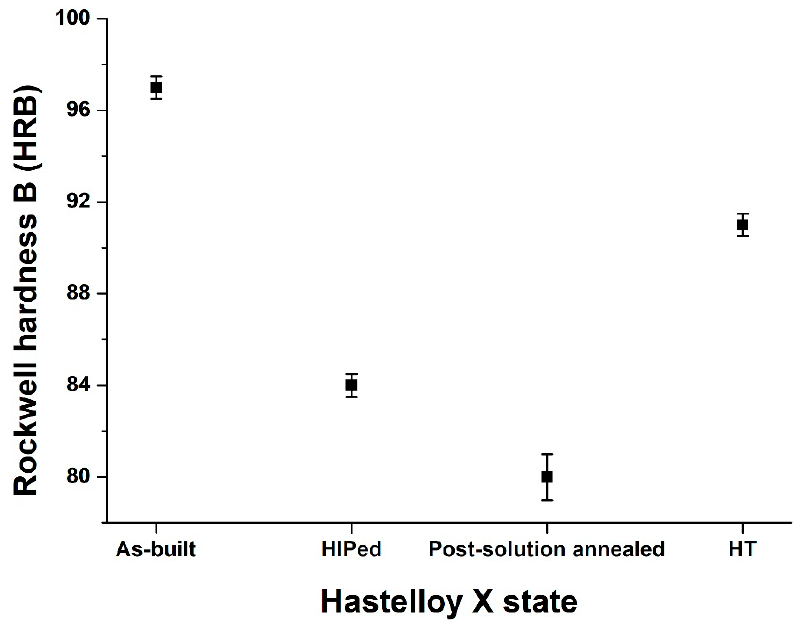
Figure 8. Rockwell hardness B (HRB) of as-built, HIPed, post-solution annealed, and HT HX states.